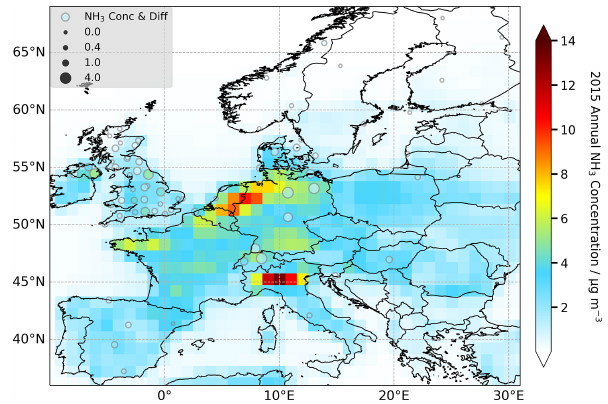
Figure 7. Modelled and measured 2015 annual mean NH 3 concen- trations in Europe. Measurements are from the UK NAMN and Eu- rope EMEP/CCC networks. Monitoring sites are indicated by cir- cles whose colour represents the measured concentration and whose diameter (see inset legend) represents the absolute difference be- tween model and